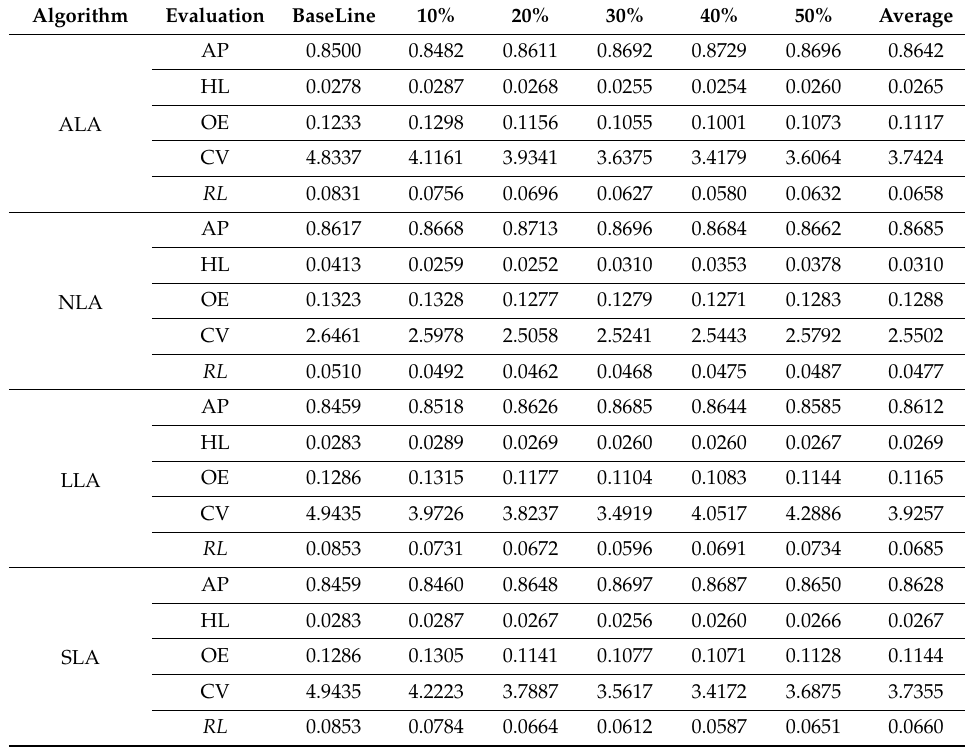
Table 4. Experimental results on Business data